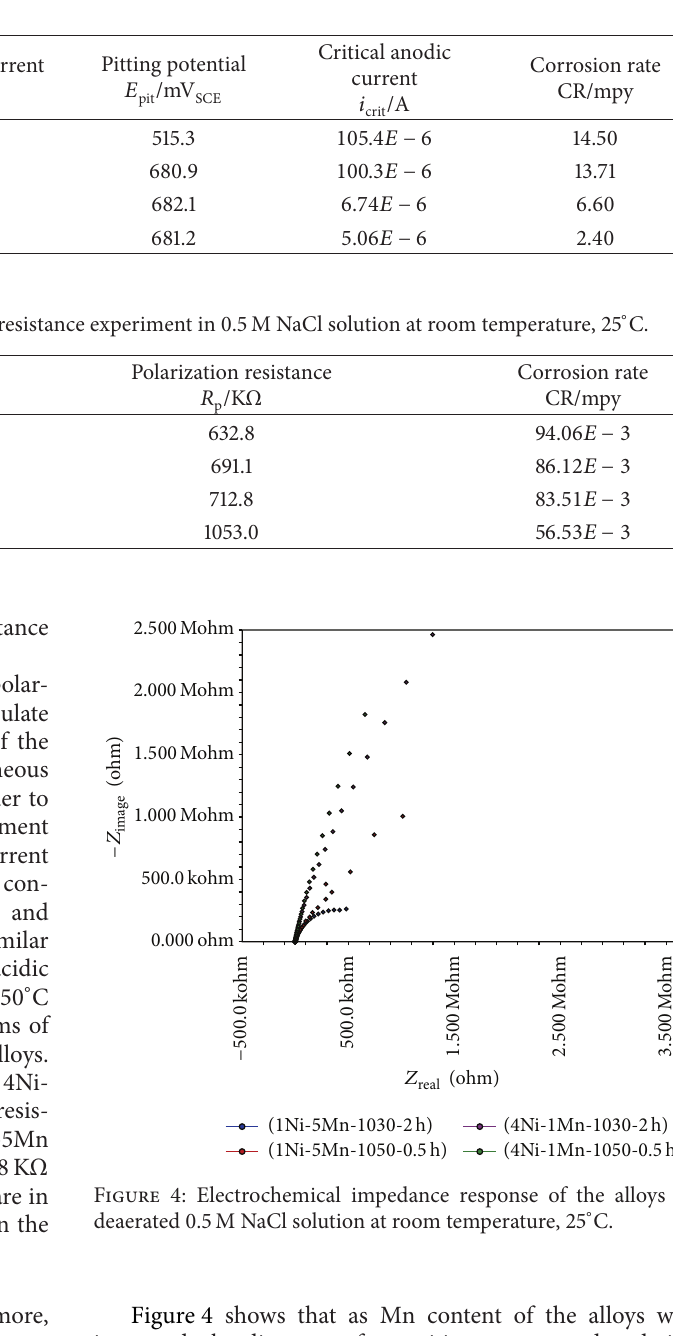
temperature, 25 ∘ C.